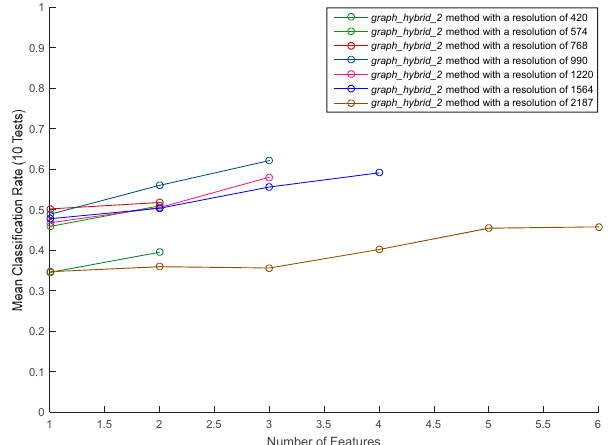
Figure 19. Performance of the neural network with the graphical method according to different resolutions.